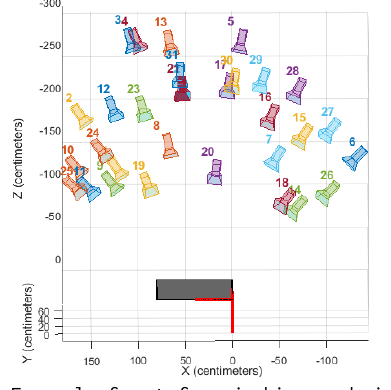
Figure 4. The distribution of the focal length estimations in function of